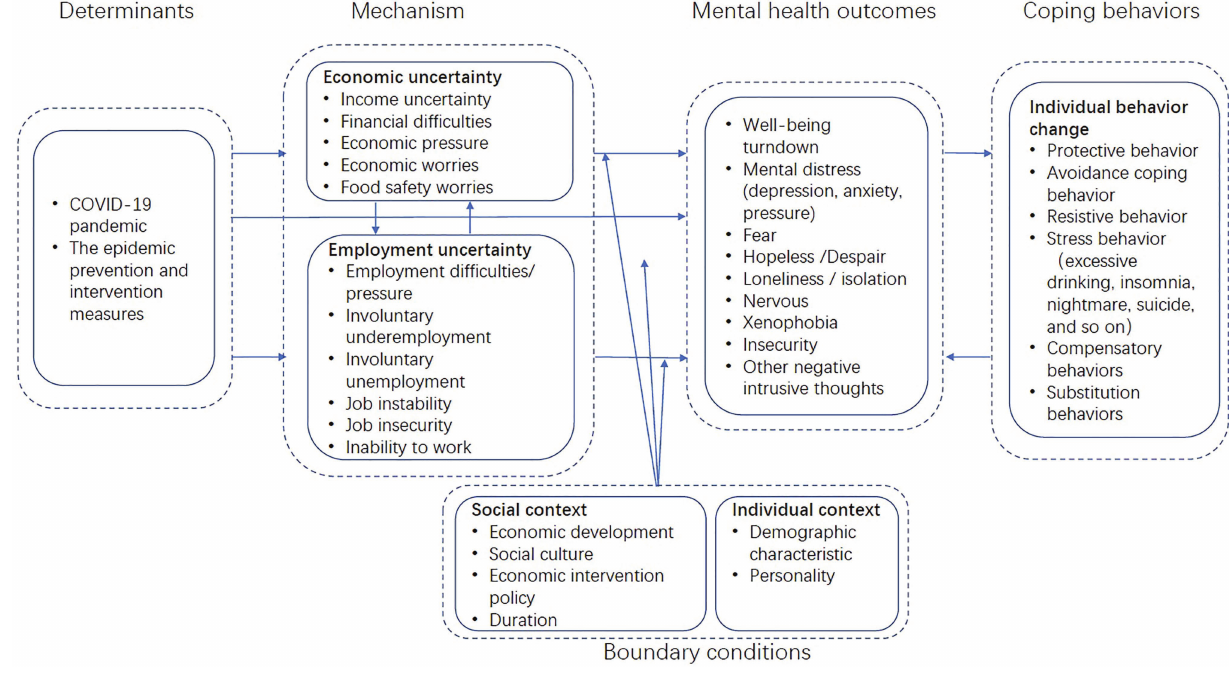
FIGURE 1 | Conceptual